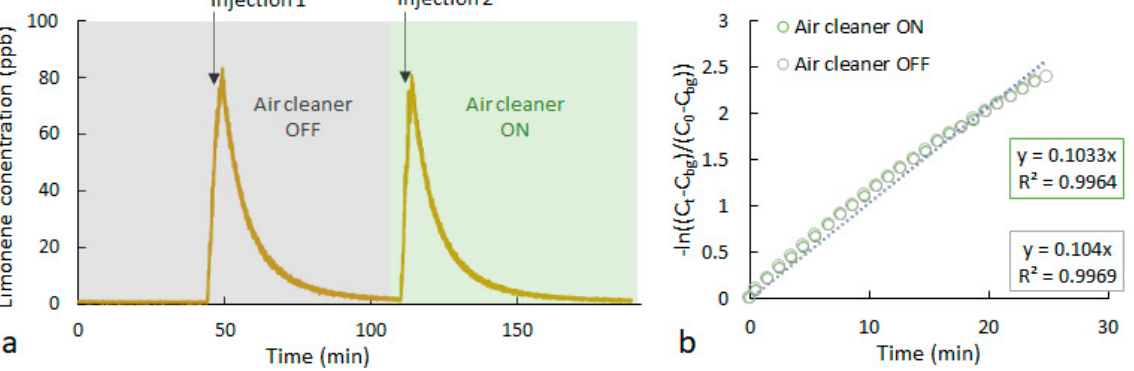
Figure 12. Example of a perturbation test with limonene injection: ( a ) time series of the limonene concentration with the air cleaner off shaded in grey and the air cleaner on shaded in green; ( b ) regression of the natural logarithm of the limonene concentrations versus time as shown in Equation (2).